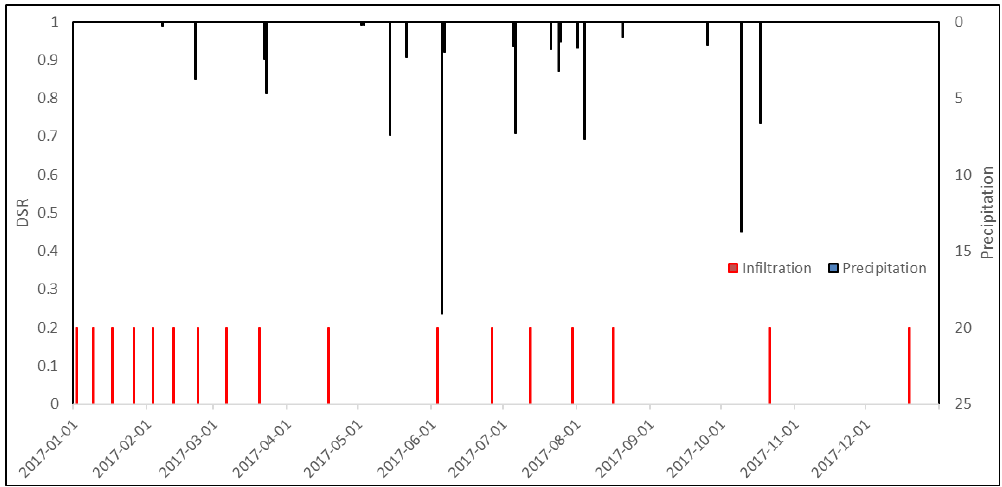
Figure 8. Relationship between precipitation and DSR in 2017 .